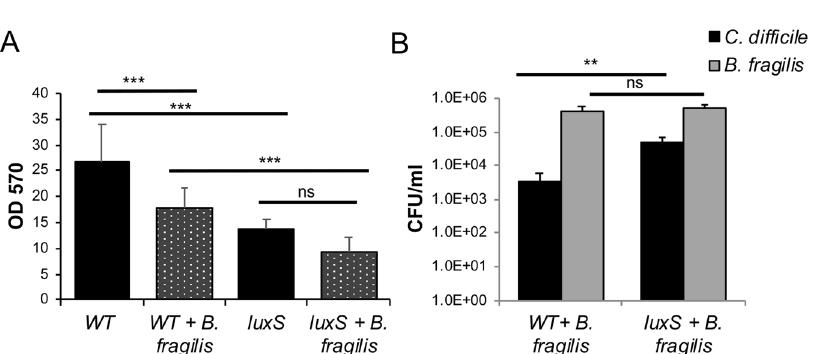
Figure 5. B . fragilis -mediated inhibition of C . difficile is more prominent for WT than LuxS . ( A ) Biofilms for mono and co-cultures of C . difficile WT and luxS with B . fragilis were grown for 24 h and stained with 0.2% CV and were quantified using a spectrophotometer OD 570 . ( B ) Colony counts for C . difficile WT, C . difficile luxS (vegetative cells) during co-culture with B . fragilis were performed at 24 h. Data shown is the mean of 3 independent experiments in triplicates and error bars indicate SD, ** p < 0.01, *** p < 0.001 as determined by one-way ANOVA, Tukeys multiple comparison test (significant differences were determined for C . difficile or B . fragilis mean CFU counts between single and mixed